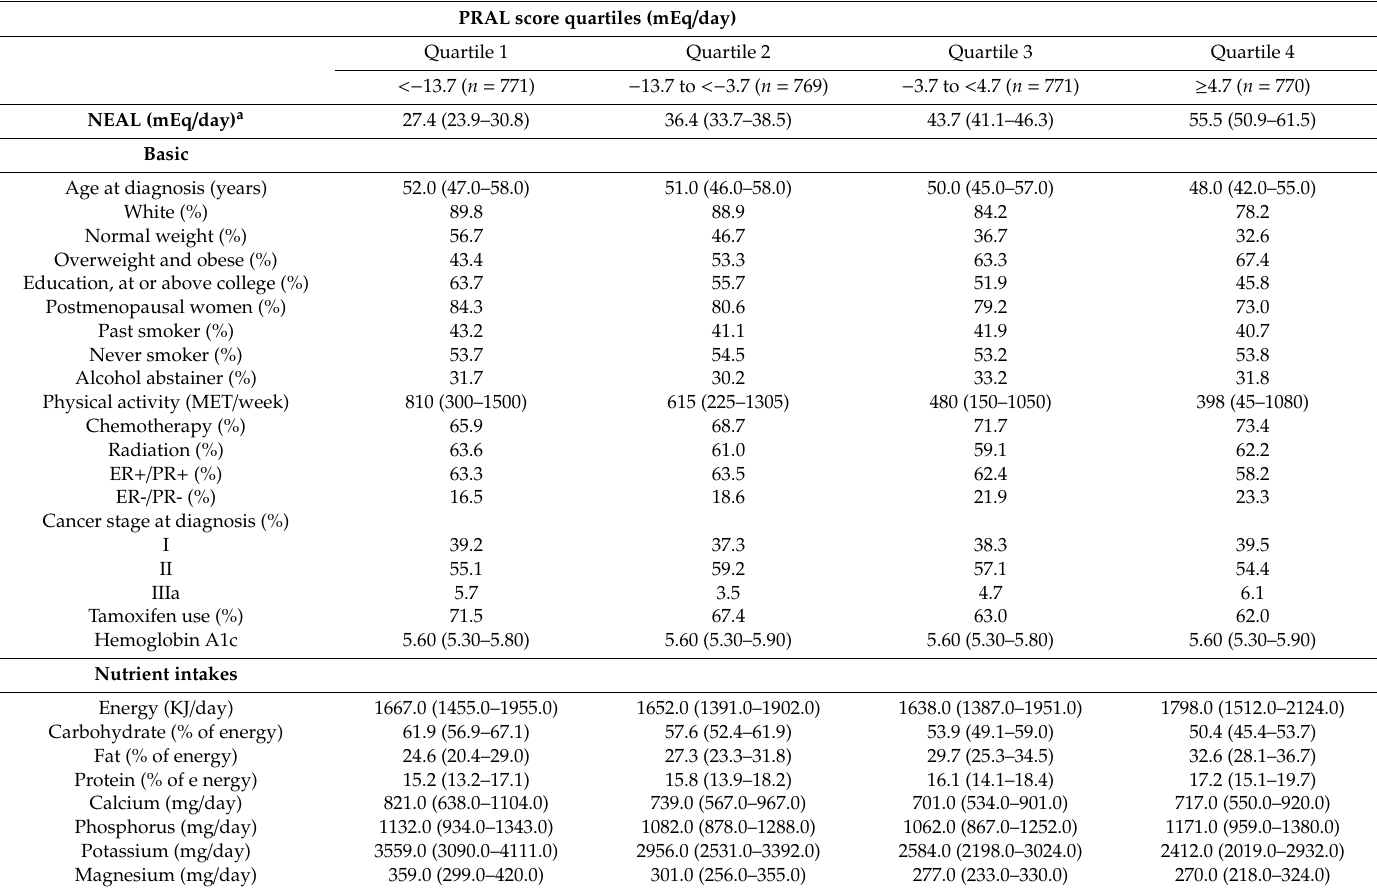
Table 2. Characteristics of breast cancer survivors at baseline by quartiles of the PRAL score ( n =